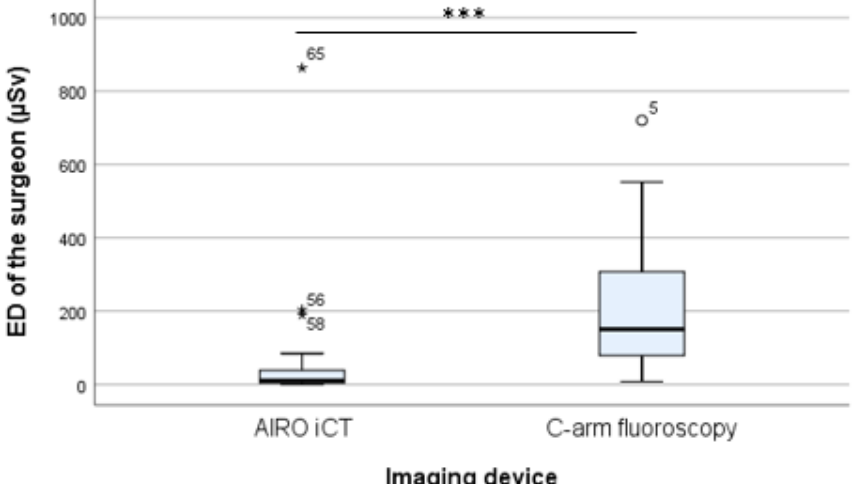
Figure 2. Effective dose of the surgeon during an MI-PLIF procedure. The ED of the surgeon (in µSv) compared between surgeries assisted by iCT ( n = 23) or C-arm fluoroscopy ( n = 41). Extreme values are marked as “ ✩ ” and outliers are marked as “°” on the boxplot. Significance ( p < 0.001) is indicated with “***” above the two boxplots.